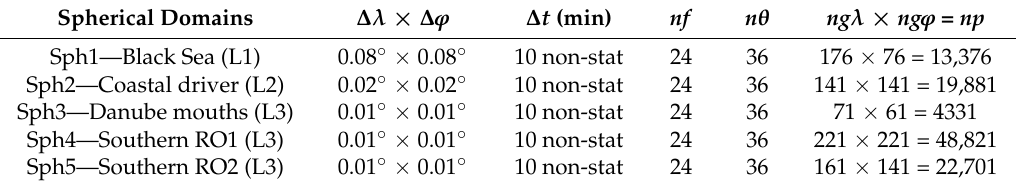
Table 1. Characteristics of the computational domains defined in spherical coordinates for the Simulating Waves Nearshore (SWAN) model simulations focused on the western side of the Black Sea. Spherical Domains